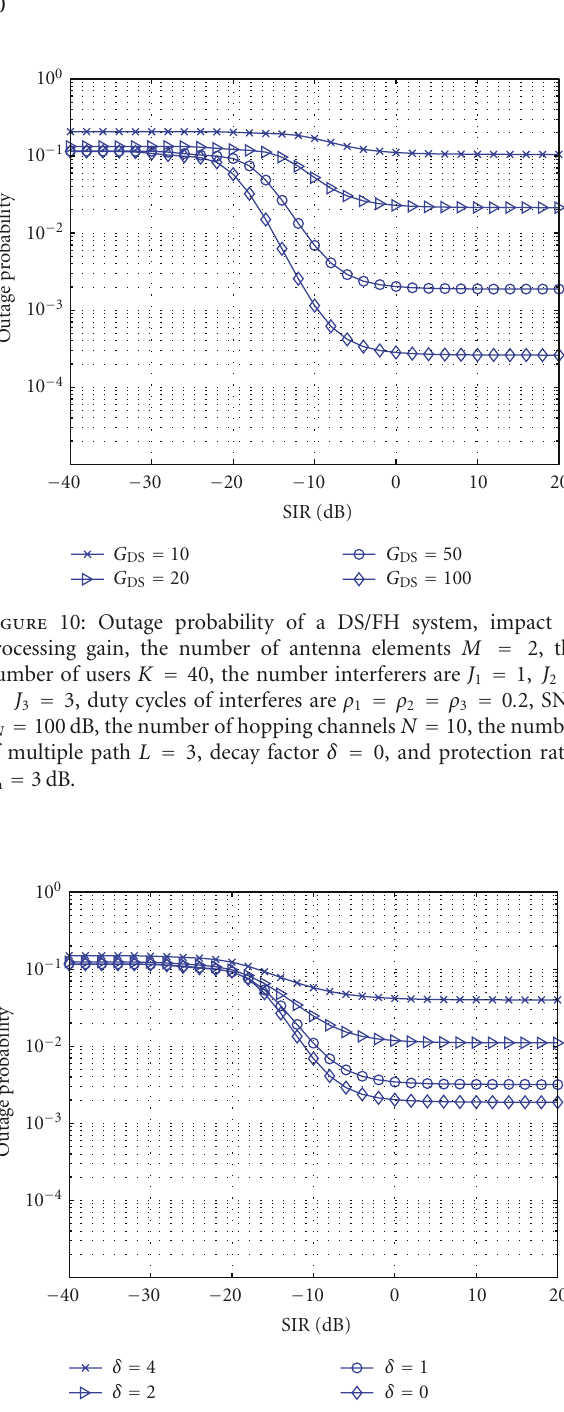
Figure 11: Outage probability of a DS/FH system, impact of the decay factor, the number of antenna elements M = 2, processing gain G DS = 50, the number of users K = 40, the number interferers are J 1 = 1, J 2 = 2, J 3 = 3, duty cycles of interferes are ρ 1 = ρ 2 = ρ 3 = 0 . 2, SNR Γ N = 100dB, the number of hopping channels N = 10, the number of multiple path L = 3, and protection ratio r th = 3dB.